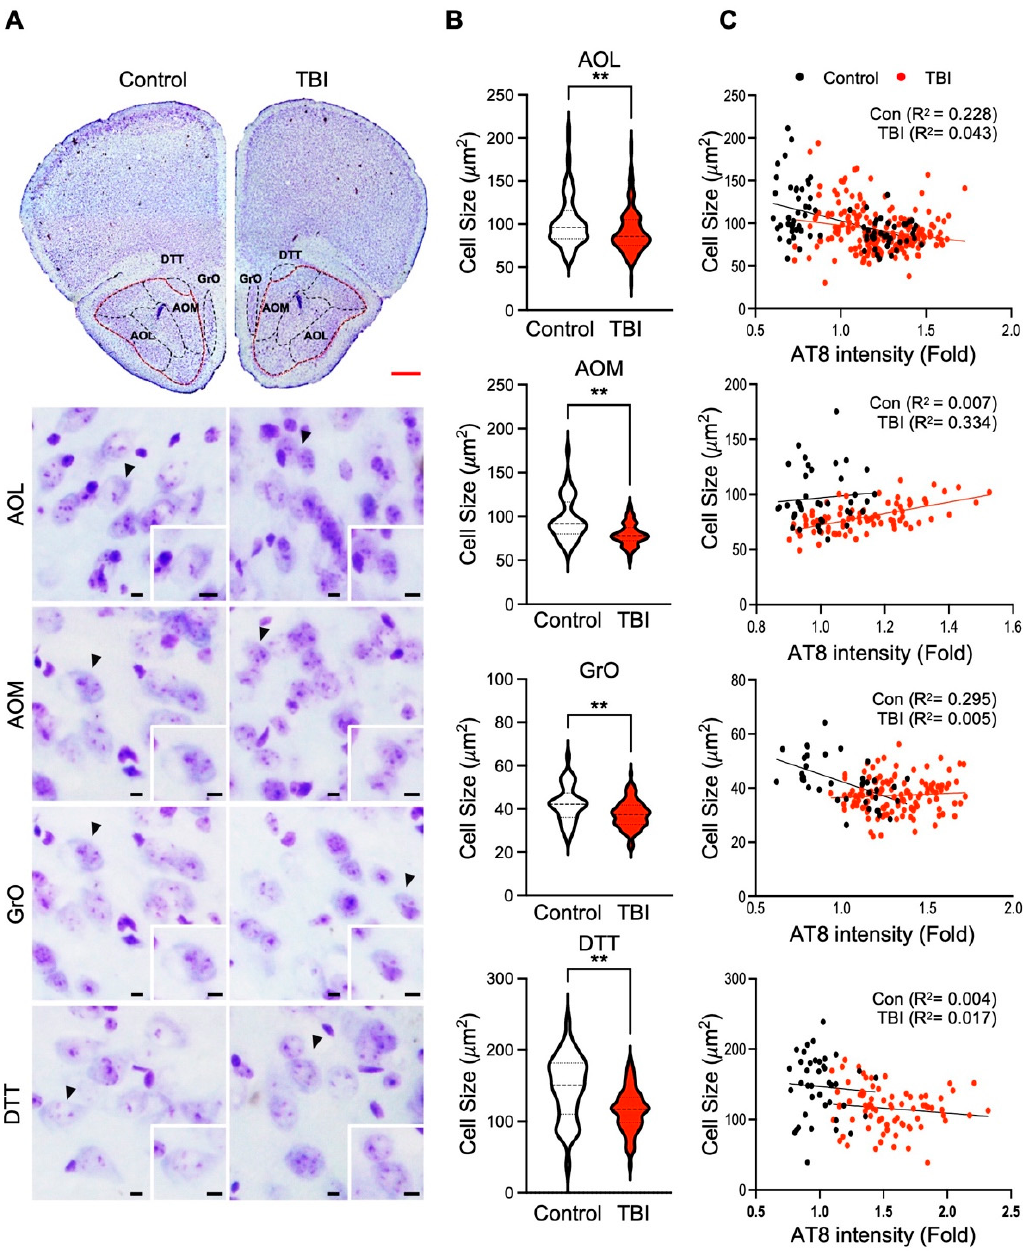
Figure 5. Neuronal size in olfactory ‐ bulb ‐ associated areas is inversely correlated with p ‐ Tau by repetitive TBI. ( A ) Neuronal size was decreased in repetitive TBI mice compared to controls. The brain tissues were stained with cresyl violet (CV). Scale bars: 500 μ m (red) and 10 μ m (black). ( B ) Cell size analysis showed a significant decrease in repetitive TBI compared to control mice in the AOL, AOM, GrO, and DTT. ( C ) Linear aggression analysis exhibited an inverse correlation between p ‐ Tau level and neuronal size in AOL, GrO, and DTT regions (control, N = 5; TBI, N = 5). Error bars indicate SEM. Significantly different from control at ** p < 0.01.